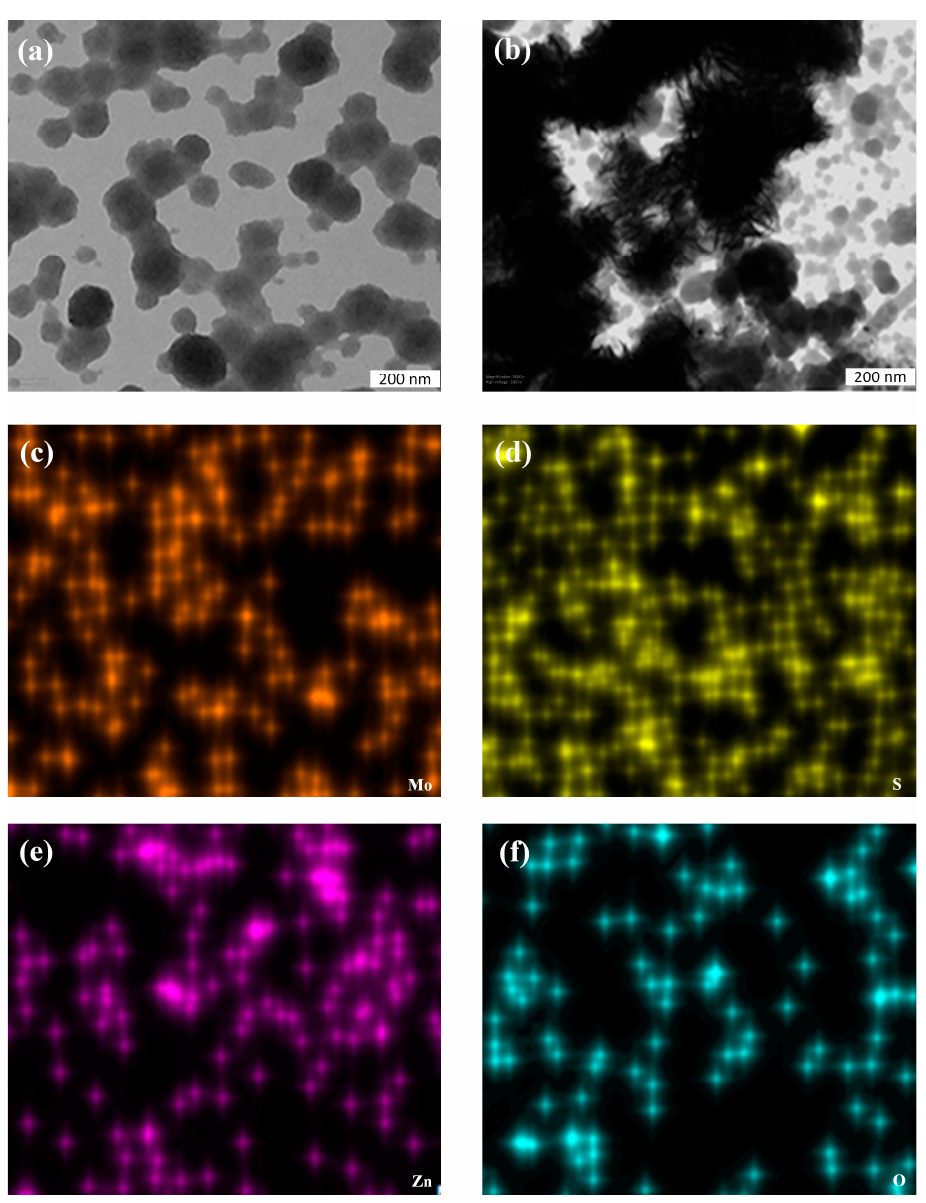
Figure 2. ( a ) HR-TEM images of synthesized ZnO; and ( b ) MoS 2 /ZnO nanocomposite. ( c – f ) EDAX spectrum of MoS 2 /ZnO nanocomposite.